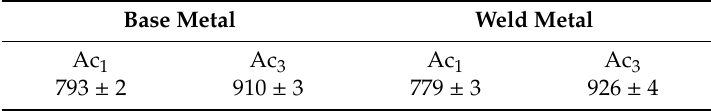
Table 4. Mean values for the Ac 1 and Ac 3 temperature of the 2.25Cr-1Mo-0.25V all-weld metal and the corresponding base metal determined by means of dilatometer measurements. All temperatures are given in °C.